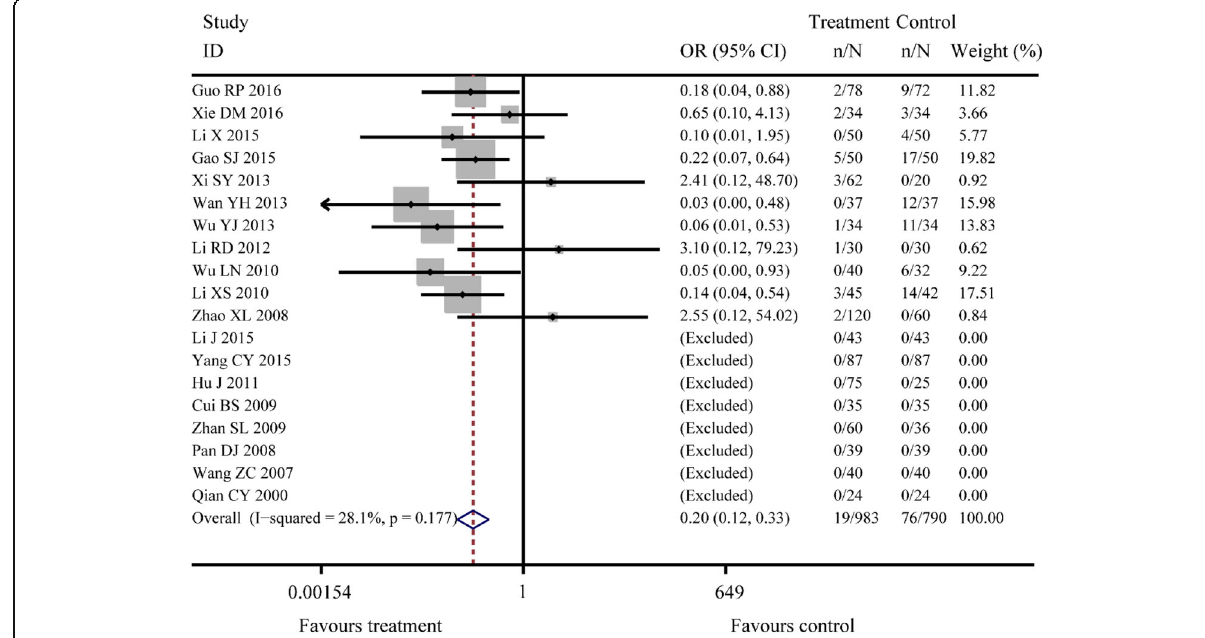
Fig. 5 Meta-analysis of adverse reaction rates about two groups